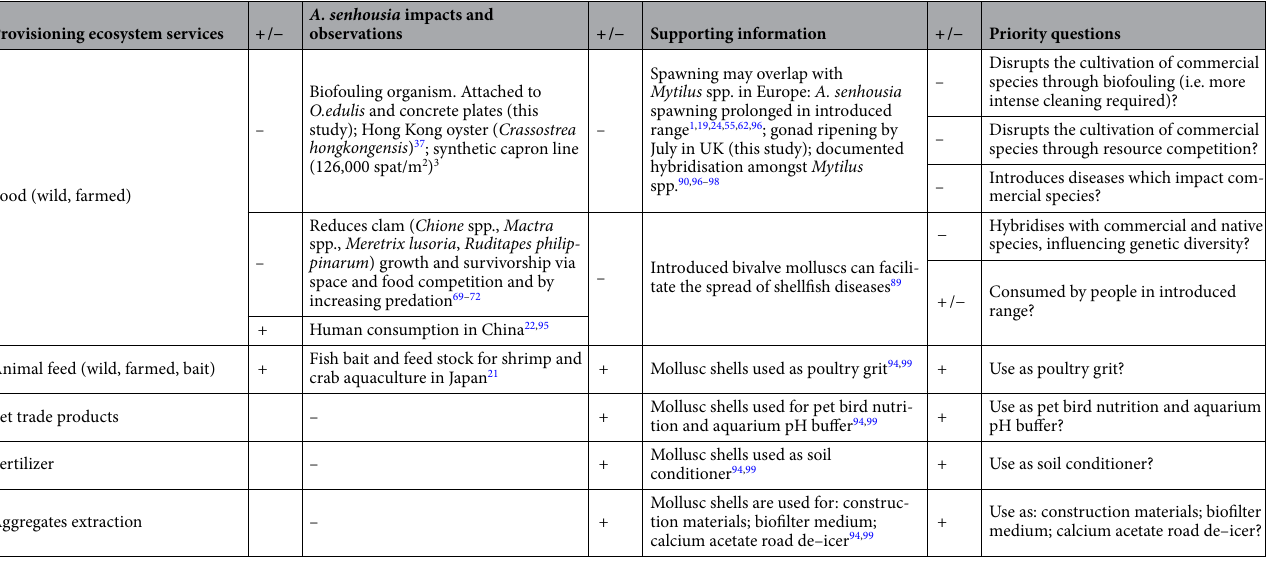
Table 2. A summary of the impacts of A. senhousia in relation to Provisioning ecosystem services. ( +) denotes a potentially positive impact, (–) denotes a potentially negative impact. Priority questions are those that should be addressed by researchers to generate a full risk assessment and management plan.